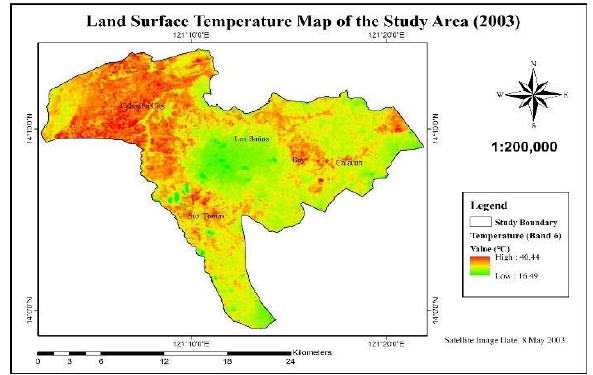
Figure 6. Land surface temperature map of the TIR band (band 6) of Landsat 7 dated May 8, 2003